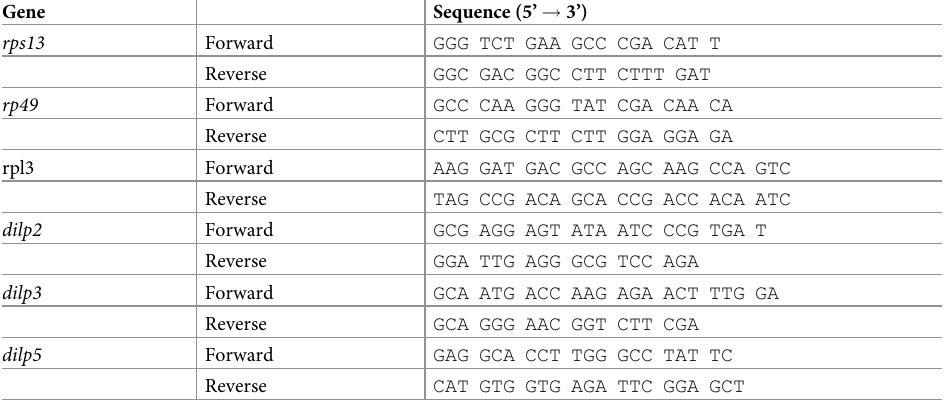
Rabbit antibodies directed against the Dilp3 partial peptide sequence DEVLRYCAAKPRT and against the Dilp5 peptide sequence RRDFRGVVDSCCRKS were generated as a service by Thermo Fischer Scientific Inc. For immunostaining, α -Dilp3 antibodies were used at a Table 2. Primers used in this